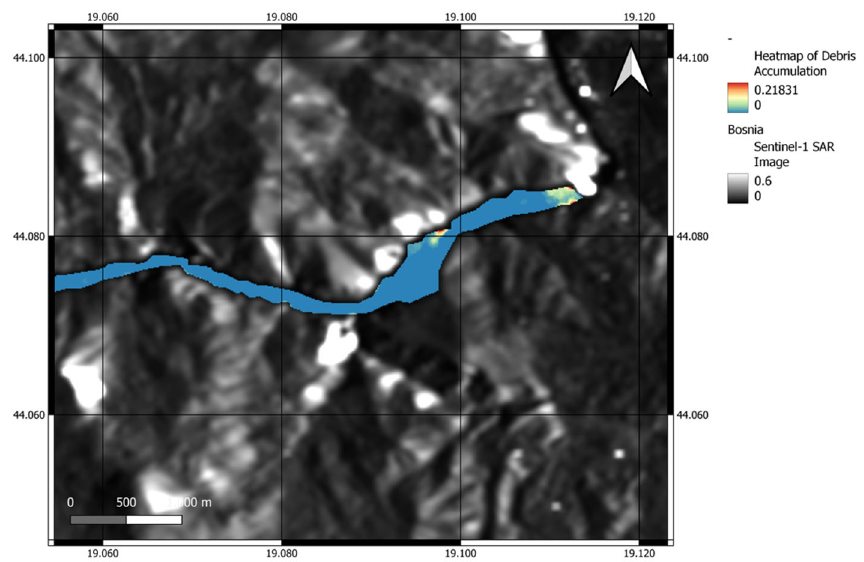
Figure 15. Heatmap of Drina River system and hydroelectric dam near Visegrad from 5 January 2019 to 26 December 2021 (total 142 acquisitions) (Sentinel ‐ 1, Credits: ESA).